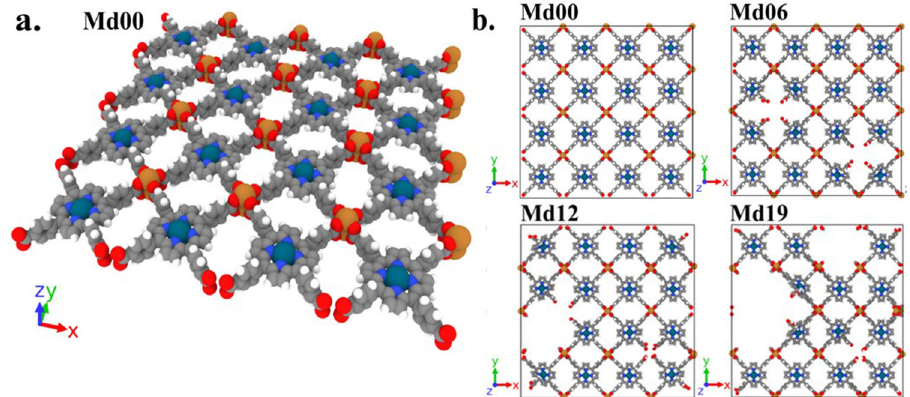
Fig. 4 Atomistic models for PdTCPP-Cu monolayer with and without defects. a Atomistic model Md00 for the defect free layer in 3D view. b Top view of four models with different defect percentage: Md00 with 0%, Md06 with 6.25%, Md12 with 12.50%, Md19 with 18.75%.